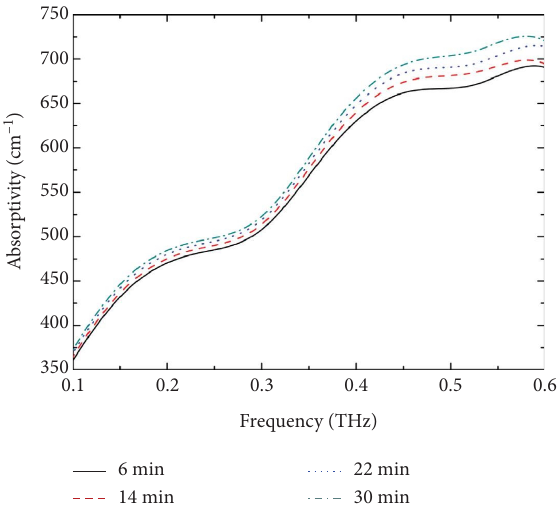
Figure 15: THz absorption spectra of MWCNTaqueous dispersion under same MF intensity and diferent